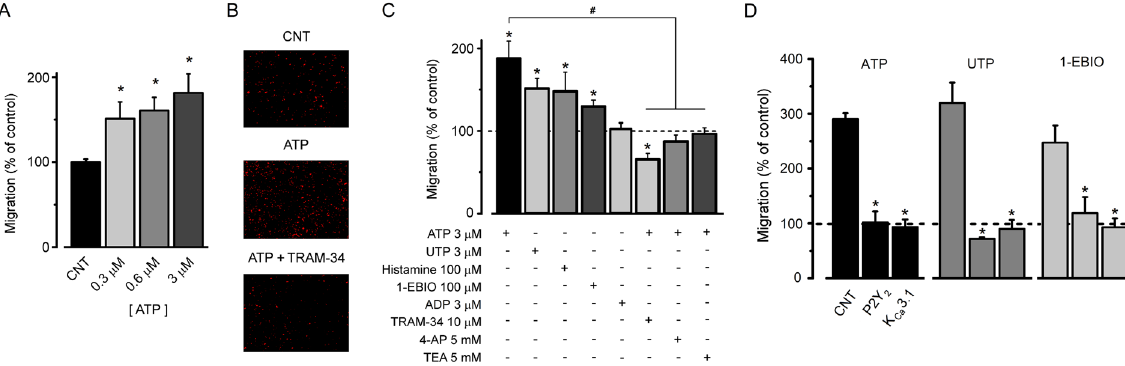
Figure 7. SKOV-3 migration promoted by ATP was inhibited by K + channel blockers or esiRNA treatment. ( A ) Bar graph shows SKOV-3 cell migration quantified after a 16-h incubation with 3 different ATP concentrations (0.3, 0.6, or 3 µ M). ( B ) ATP-promoted migration was evaluated in different conditions. Images illustrate cell migration in control condition without added ATP, with 3 µ M ATP, and 3 µ M ATP co-applied with 10 µ M TRAM-34. ( C ) Bar graph shows cell migration normalized against control. Cells were incubated in different conditions as indicated by + signs in experiments like those shown in ( B ) ( * p < 0.05, experimental condition vs. control without treatment). Note that drugs that activate the K + response promoted migration, while K Ca 3.1 blockers (last 3 bars) in the presence of ATP significantly inhibited migration to basal level, or even below, as in TRAM-34 application ( * p < 0.05, compared vs. control without treatment). Migration in the presence of K + blockers was also statistically different with respect to ATP-promoted migration ( # p < 0.05). The data represent means ± S.E.M. of 3 different culture preparations. ( D ) SKOV-3 cells after 48 h of treatment with esiRNA were assayed for migration promoted either by 3 µ M ATP, 3 µ M UTP or 300 µ M 1-EBIO. For each drug treatment the distinct esiRNA transfection conditions were evaluated as in Fig. 5 and indicated in the set stimulated with ATP ( * p < 0.05, experimental condition vs. respective CNT).